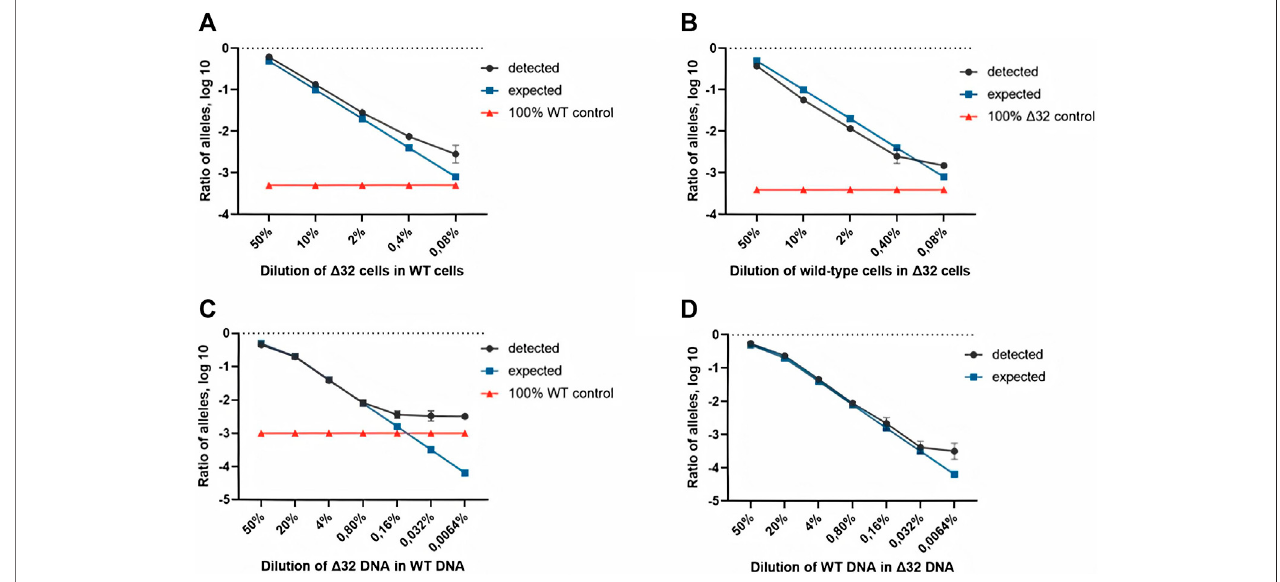
FIGURE 3 | Comparison of both ddPCR assays using the MT4 cells (A,B) and genomic DNA (C,D) as test materials for serial dilution. The blue line indicates the expected ratio.